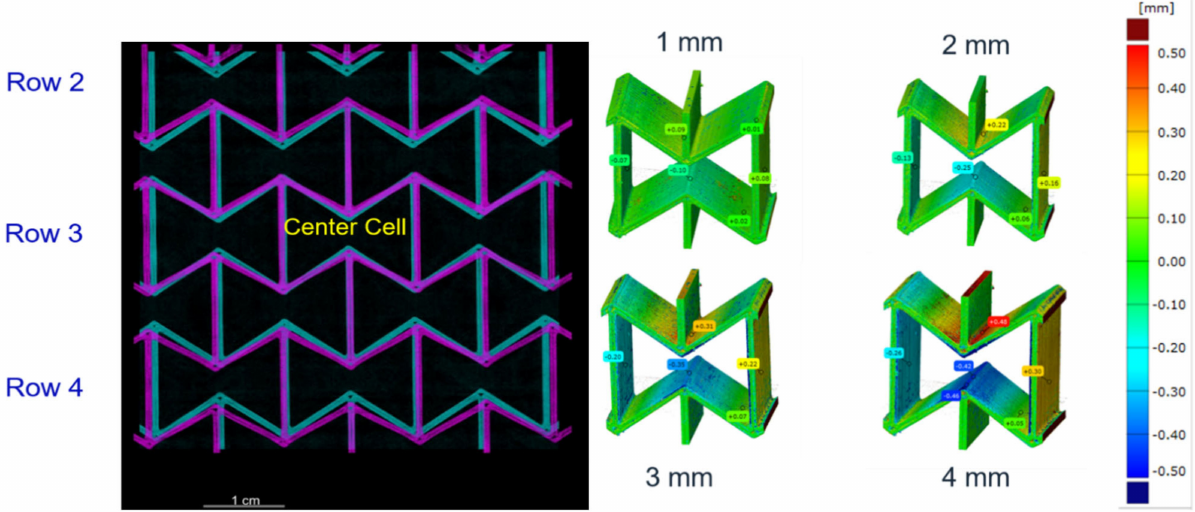
Figure 18. Auxetic deformation behavior of a 5 × 5 PLA sample: overlapping of the sample state at loadings of 0 mm (cyan) and 4 mm (magenta) loading ( left ); the measured local displacement of the center honeycomb using 2D-DIC ( right